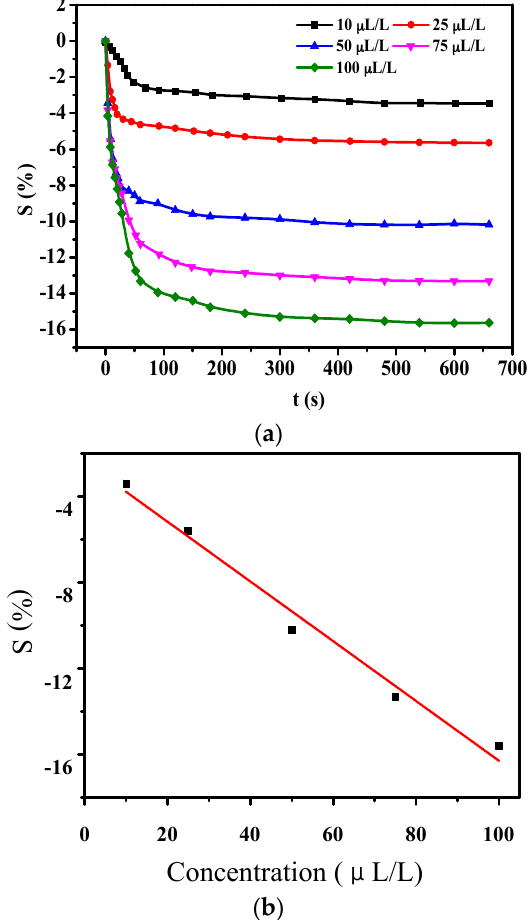
Figure 6. Gas-sensing response of PANI-SSA sensor to H 2 S of different concentration. ( a ) Response to a range of concentration of H 2 S; ( b ) Liner relationship between sensitivity and gas concentration.